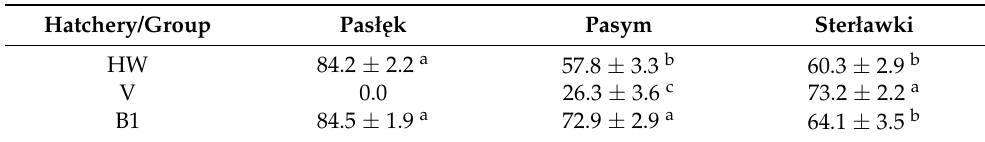
Table 3. Hatching rates with different activation media at different field hatcheries. Data are means ± SD. Values in columns with different letter indices differ significantly (Tukey’s multiple range tests at p < 0.05). Hatchery/Group Pasł˛ek Pasym